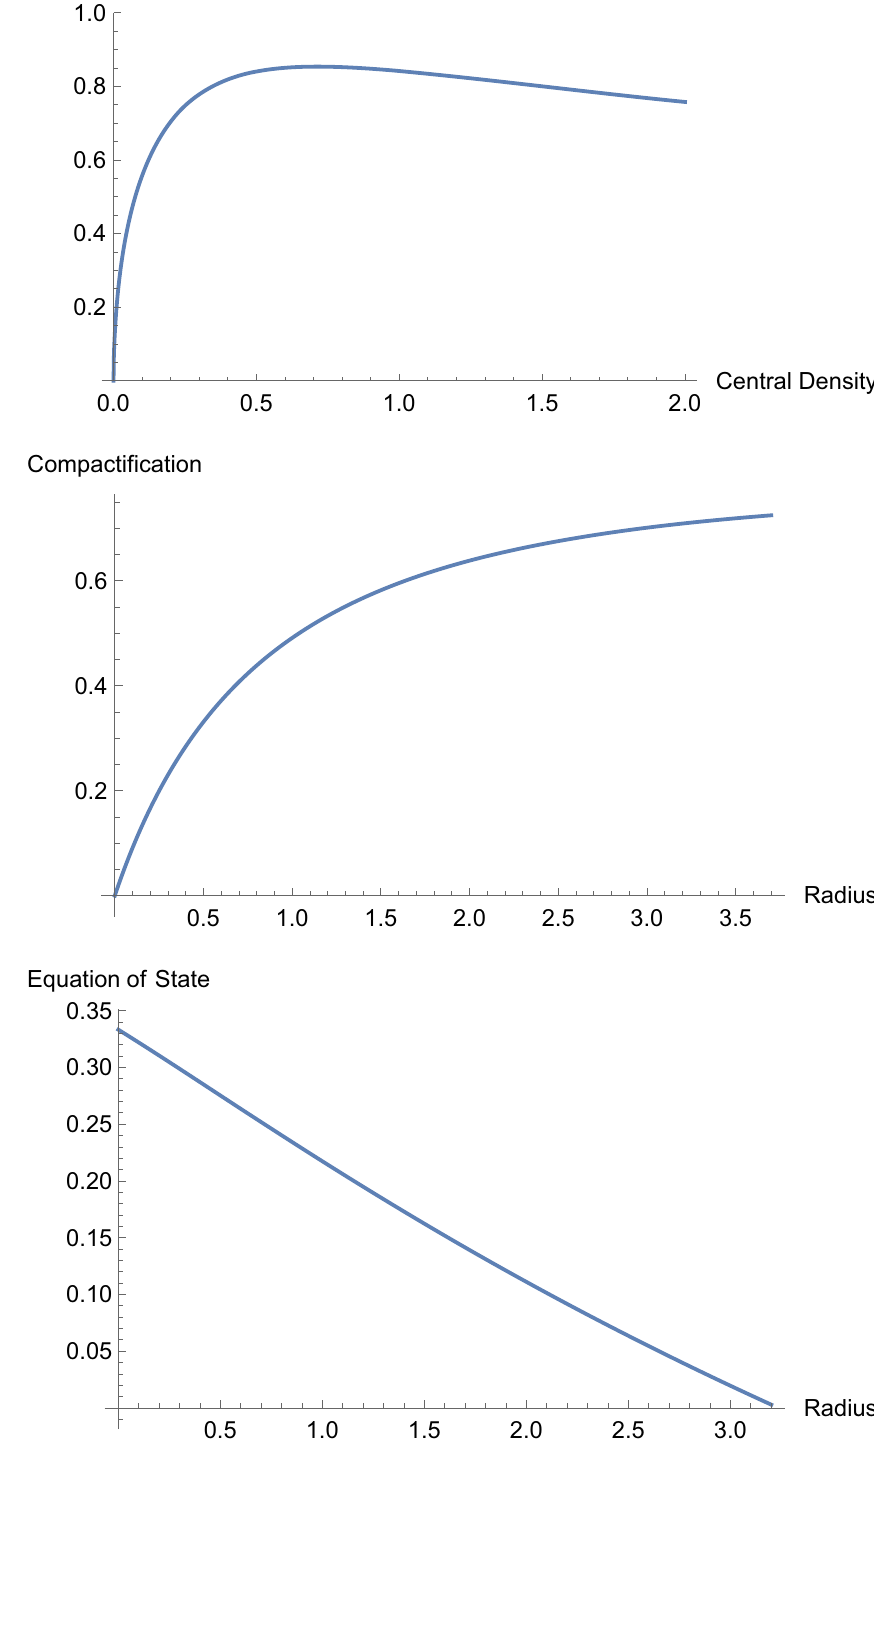
Fig. 8 Compactification versus the radial variable x